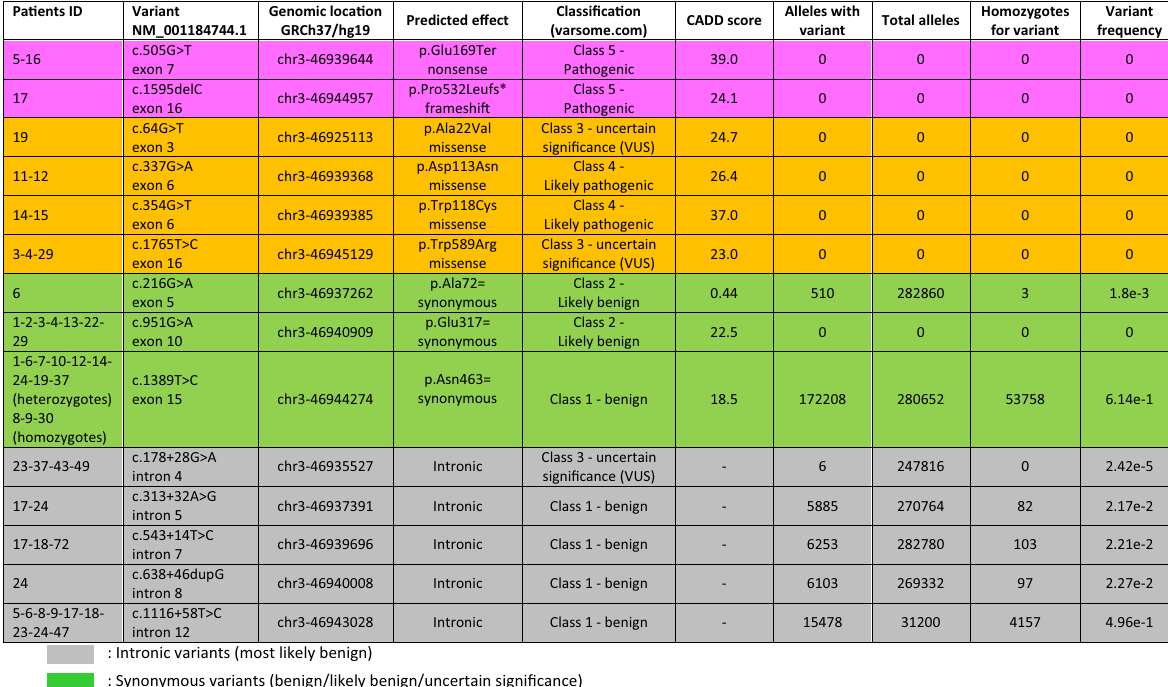
Table 2 PTH1R variants found in our cohort with their cDNA and genomic location, predicted effect and classification, CADD scores for exonic variants, and frequency in